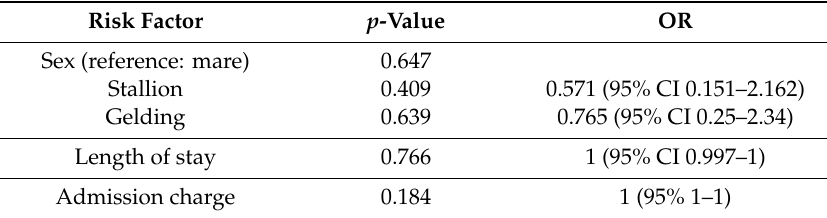
Table A3. Risk factor analysis for ESBL-E shedding by horses on admission to hospital (logistic